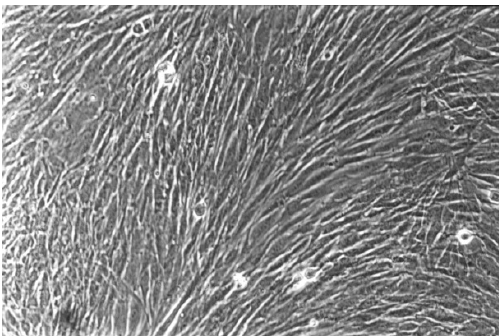
** viable: p = 0.002; same asterisks show significant di ff ernces in the corresponding groups).